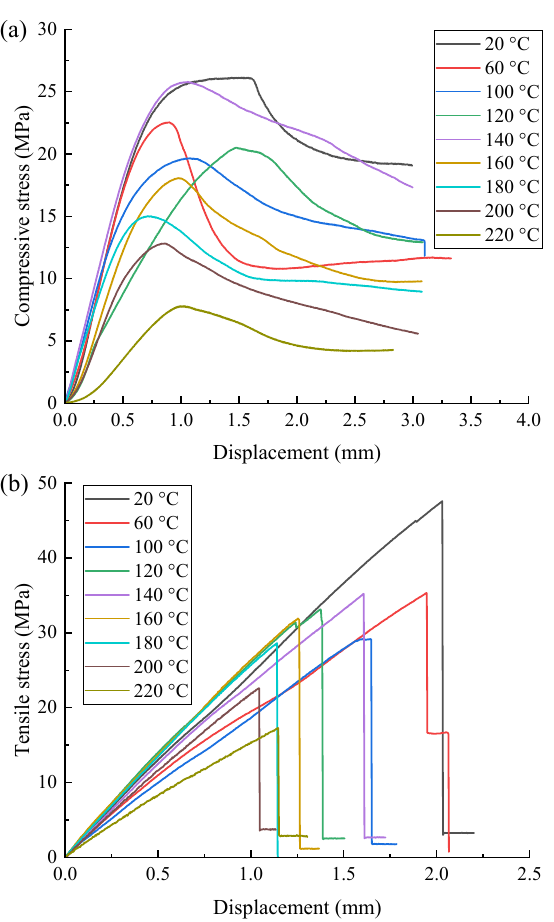
Figure 9. Stress-displacement responses of all the specimens in tension.